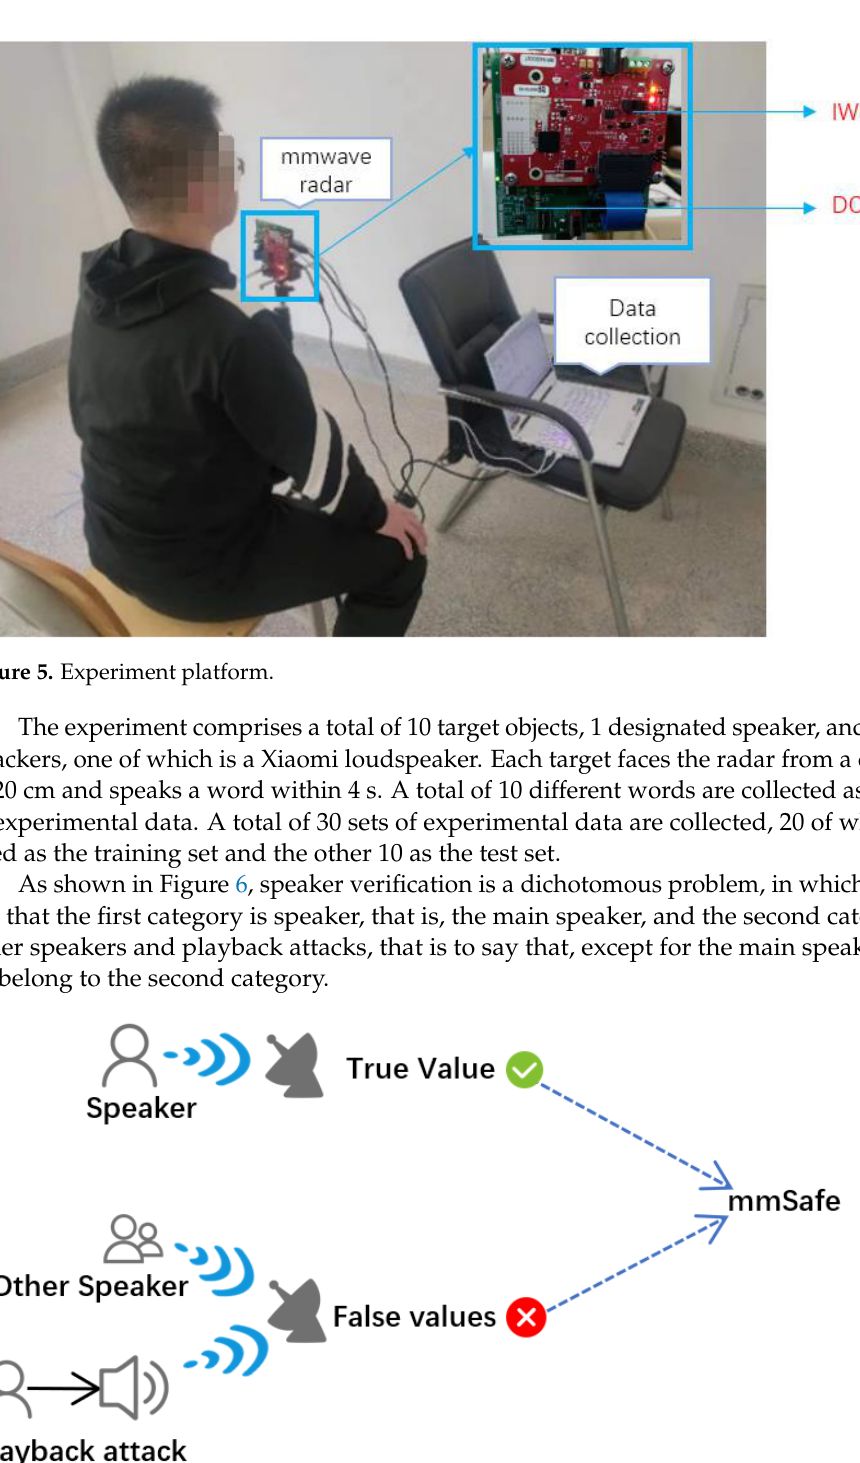
Figure 6. Significance of experimental data.